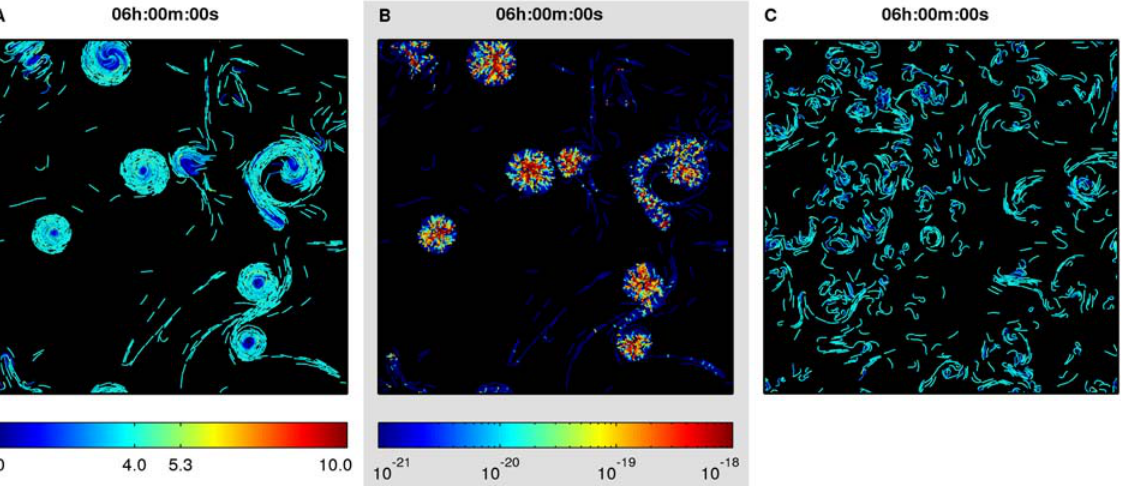
Fig 4. Effect of long-range guiding forces on cell movement patterns in a low-density population. Initial configuration of cells is random, as in Fig 2A. (A) Final configuration of a population of rigid cells at 6 h. Color indicates speed of individual cells, μ m (cid:2) min − 1 . (B) Strain energies due to cell overlap in population of rigid cells, J. (C) Final configuration of a population of flexible cells at 6 h. Color indicates speed of individual cells (see colorbar in (A), μ m (cid:2) min − 1 ).